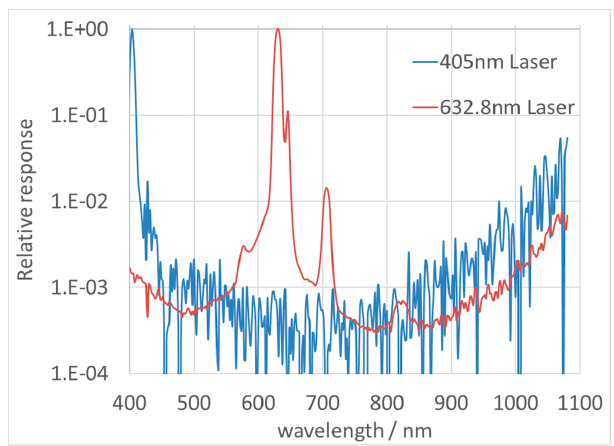
Figure A6. Relative response on each pixel (relative to central wavelength response) to a monochromatic 632.8 nm laser and a monochromatic 405 nm laser.